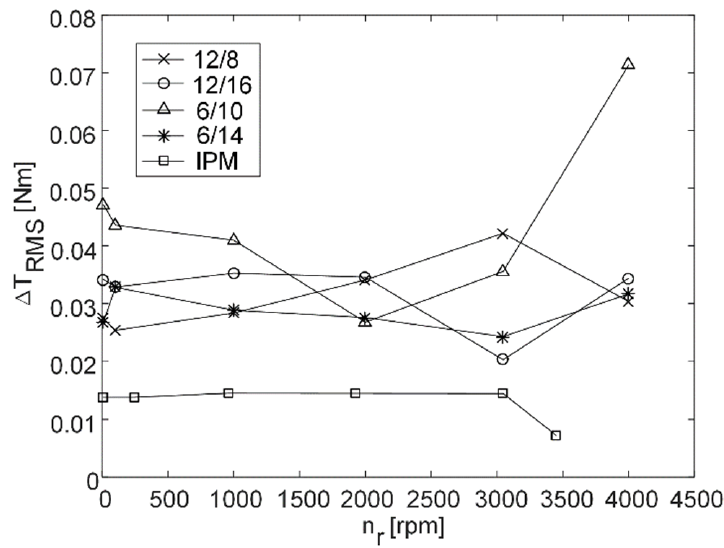
Figure 16. Torque ripple values at different speeds and nominal current.